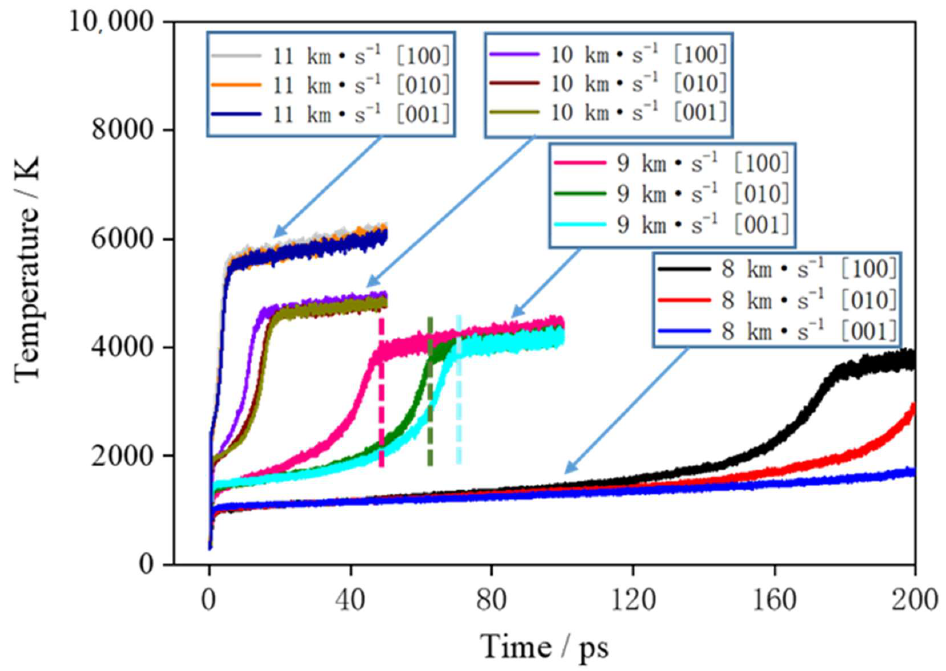
Figure 4. Evolution of temperature at different shock velocities. Taking the TNAZ supercell at 9 km · s − 1 as an example, the stage from 0 ps to the position of the dotted line is the rapid reaction stage. The stage from the position of the dotted line to 100 ps is the slow reaction